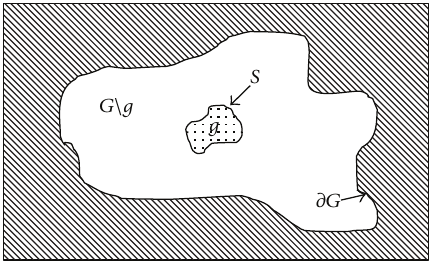
Figure 2: Inside object 𝐺 , interior region 𝑔 bounded by surface 𝑆